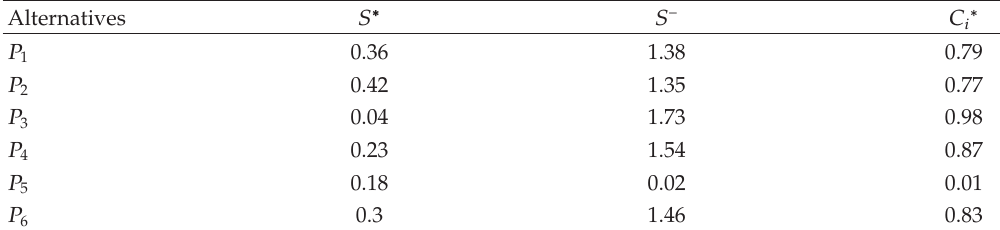
Table 7: Separation measures and the relative closeness coe ffi cient of each